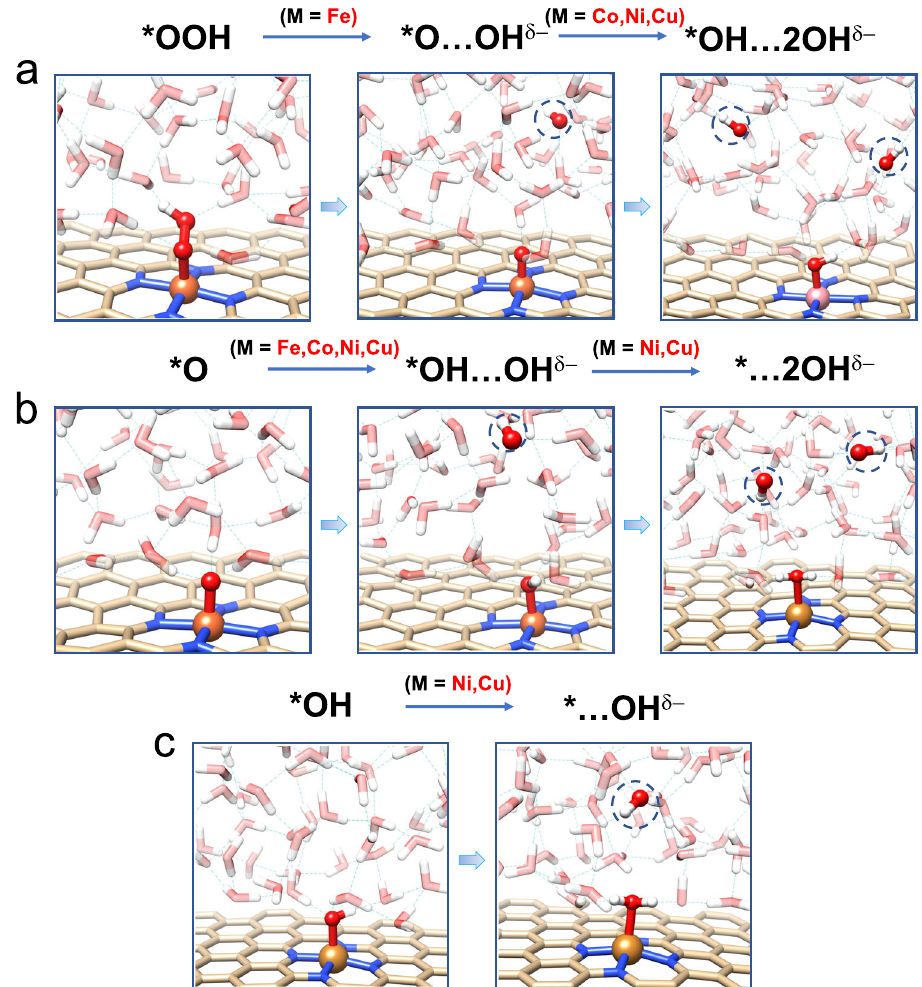
Fig. 1 MD Snapshots of reaction intermediates transforming to the pseudo-adsorption state. a *OOH species forms hydrogen bonds with the surrounding water molecule and quickly dissociates into an adsorbed oxygen (*O) species and a hydroxyl dissolving into the water on Fe – N 4 /C catalyst. Further protonation could be observed on Co – N 4 /C, Ni – N 4 /C, and Cu – N 4 /C catalysts. b *O catches proton from solvent environment to form *OH … OH δ − . For Ni – N 4 /C and Cu – N 4 /C catalyst, further protonation to form * … 2 OH δ − was observed. c the protonation of *OH could be observed on Ni – N 4 /C and Cu – N 4 /C catalyst. The Fe, Co, Cu, N, C, O, and H atoms are colored in brown, pink, orange, blue, light yellow, red, and white,